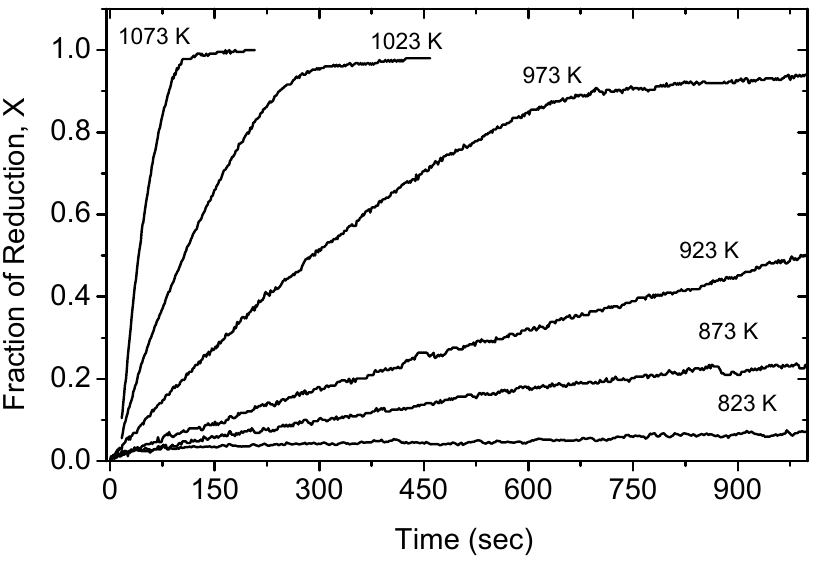
Figure 1. The isothermal reduction curves of shallow powder beds FeMoO 4 by hydrogen [2].